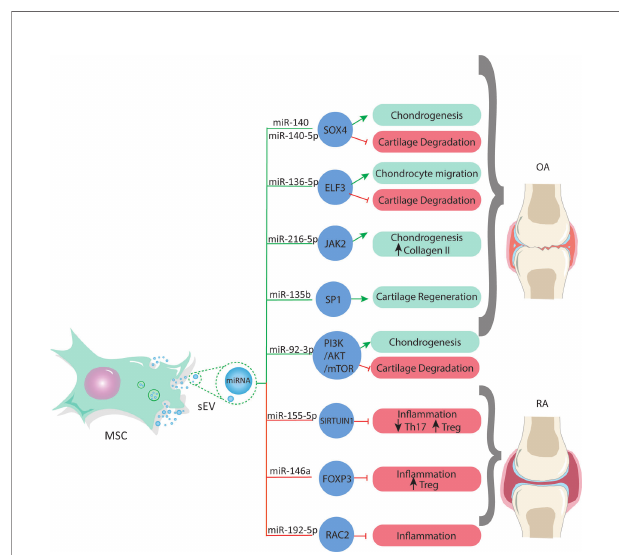
FIGURE 1 | MSCs release sEVs with a miRNAs cargo that regulate gene expression by targeting transcription factors associated to different processes in osteoarticular diseases. These miRNA can be used to develop new and effective therapies for OA and